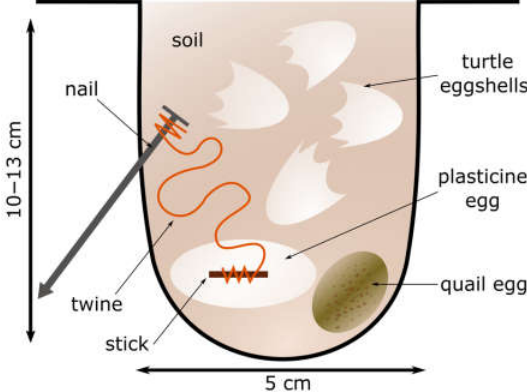
Figure 2. Schematic drawing of artificial turtle nest.